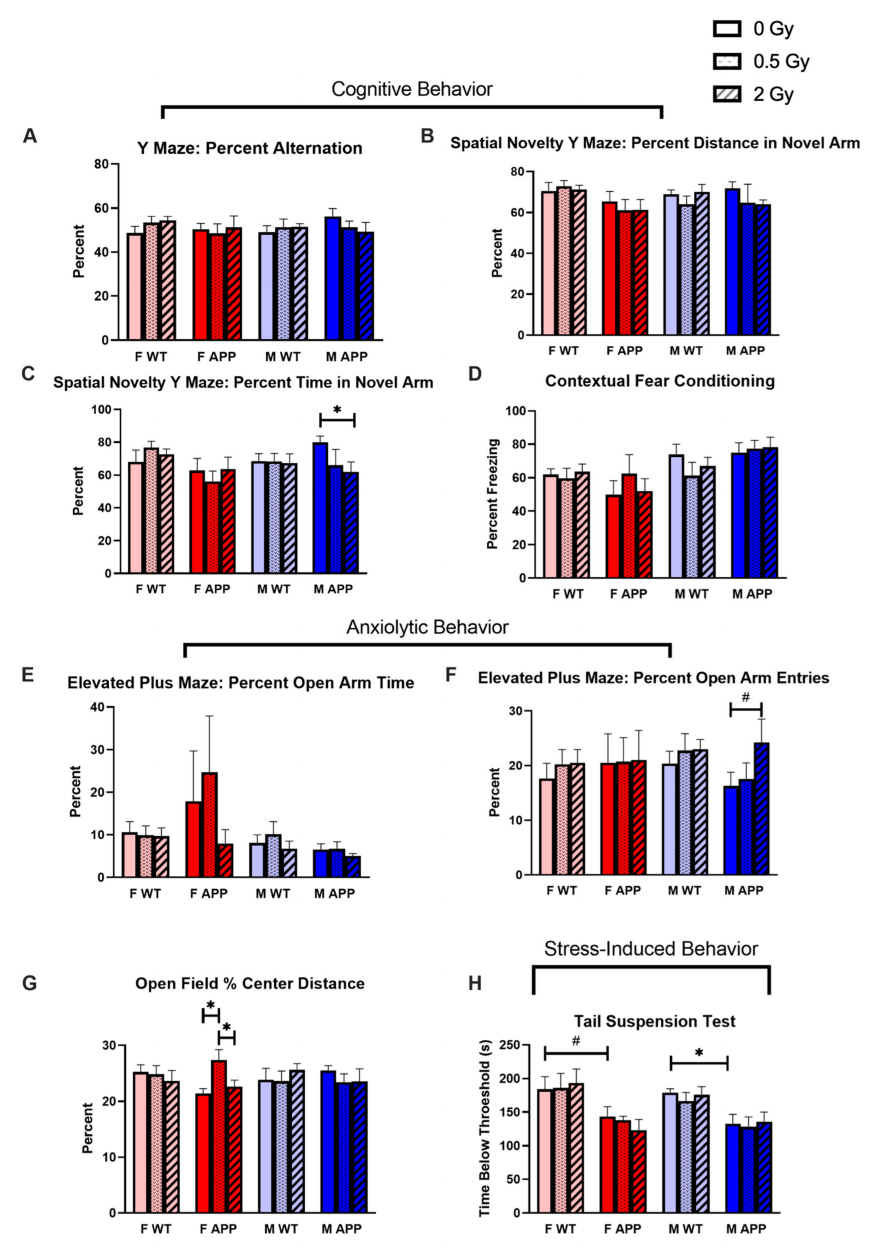
Figure 2. Changes in cognitive behaviors 7 months after a single dose of whole-body proton irra- diation depend on sex, genotype, and dose. Four-month-old male and female APP/PS1 (Tg) mice and WT littermates were irradiated with 0, 0.5, or 2 Gy of whole-body proton irradiation at BNL and a subset of these mice ( n = 7–8 mice/group) went through behavioral tests starting at 7 months post-irradiation. ( A – D ): Proton irradiation had no statistically significant effect on memory function by 3-way ANOVA as assayed by the ( A ) Y maze, ( B , C ) spatial novelty Y maze, and ( D ) contextual fear conditioning tests. However, multiple comparison testing reveals a significant radiation-induced reduction in spatial novelty Y maze performance in only male Tg mice. ( E – G ): Proton irradiation had no statistically significant effects on anxiolytic behavior by 3-way ANOVA. However significant pairwise differences were observed in ( F ) the proportion of open arm to closed arm entries in the elevated plus maze for male TG mice and in ( G ) the proportion of center to peripheral distance trav- elled in the open field test for female Tg mice. ( H ): Proton irradiation had no effect on stress-induced behavior. #: p < 0.1, *: p < 0.05. Data were analyzed by 3-way ANOVA followed by 1-way ANOVAs of male and female mice with Fisher’s Least Significant